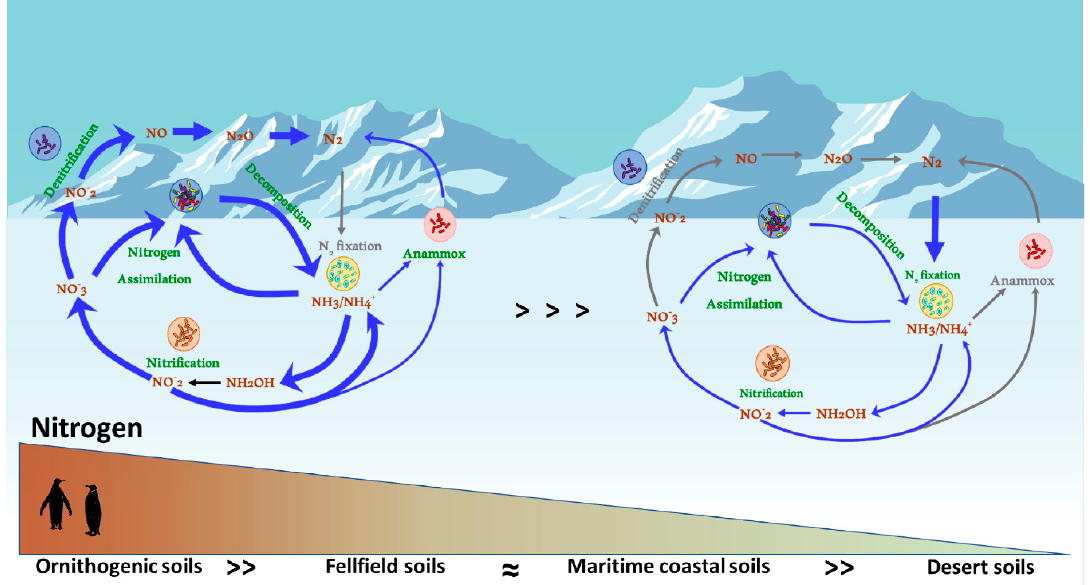
Figure 1. N-cycling processes in Antarctic soils, across the nitrogen hetero-oligotrophy spectrum. Line colour and thickness represent the relative importance of the individual N biotransformation processes in the various soil types.